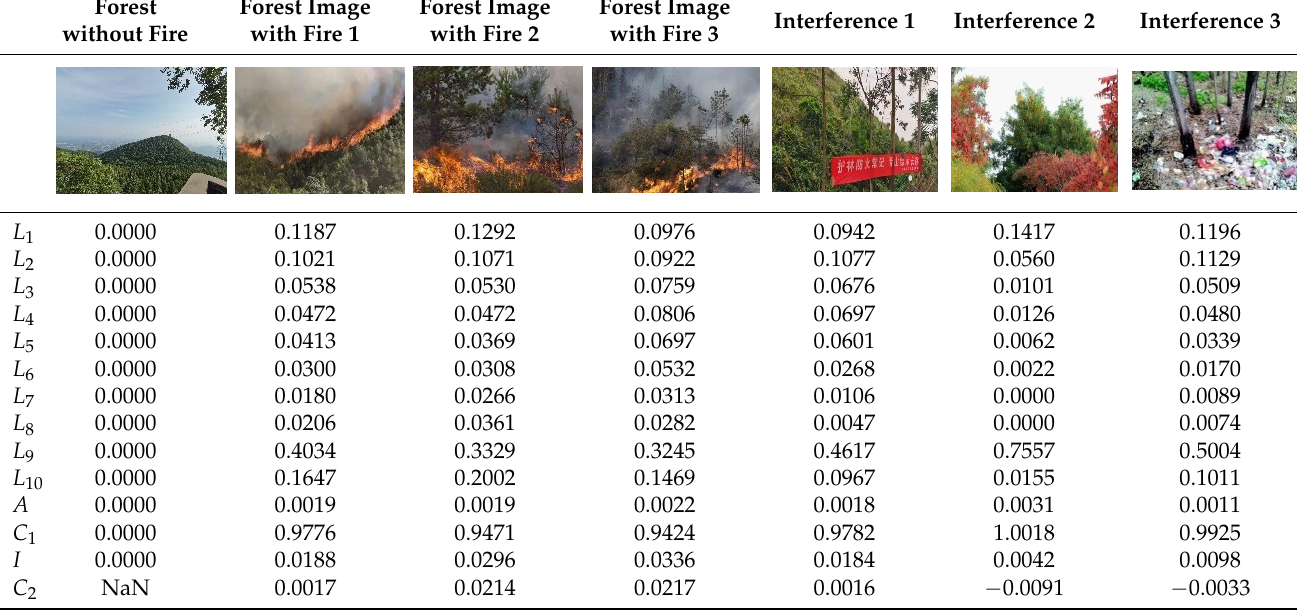
Figure 10. Experimental image sample and extraction results: ( a1 ) forest image without fire; ( a2 ) color extraction result of forest image without fire; ( a3 ) LBP extraction result of forest image without fire; ( a4 ) gray image of forest image without fire; ( b1 ) forest image with fire; ( b2 ) color extraction result of forest image with fire; ( b3 ) LBP extraction result of forest image with fire; ( b4 ) gray image of forest image with fire; ( c1 ) forest image with fire-like interference; ( c2 ) color extraction result of forest image with fire-like interference; ( c3 ) LBP extraction result of forest image with fire-like inter- ference; ( c4 ) gray image of forest image with fire-like interference. Table 3 shows the image and feature vectors of the typical image samples used in this study, and Table 4 shows the forest fire identification results under different algorithms. Table 3. Fusion feature vector of partial forest sample image and color texture.